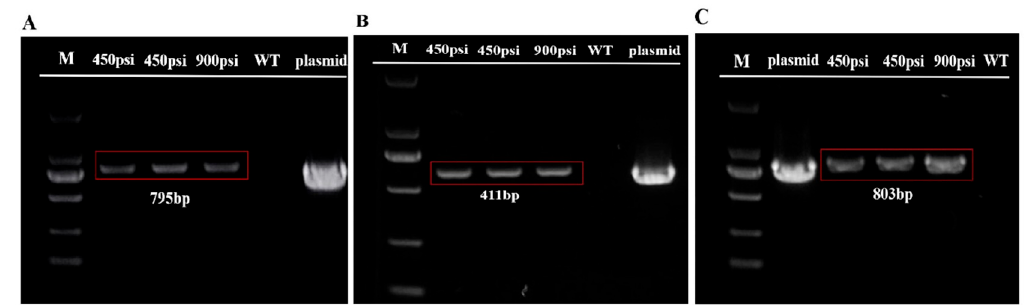
Figure 5. PCR amplification from genes using the genomic DNA of T. minus transformants and wild types (marker: DL2000). Gel analysis of the npt Ⅱ ( A ) and eGFP genes ( B ) in transformants and wild types. ( C ) Gel analysis of fragment in pEASY- tub-npt Ⅱ in third-generation transformants and wild types.